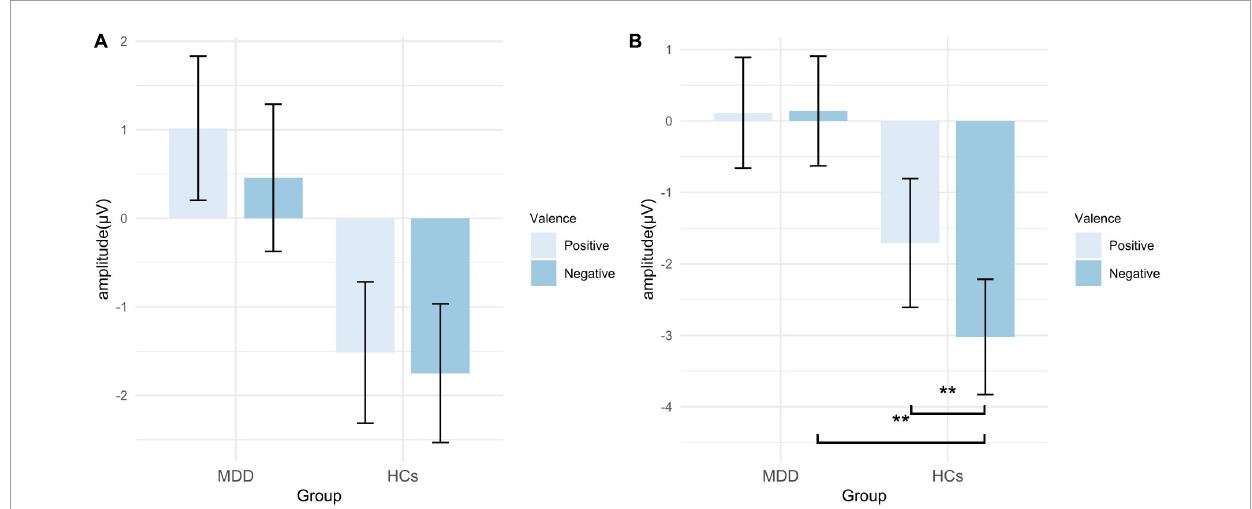
FIGURE4 Peak amplitude of N200 in EAST. (A) Amplitudes of self-words; (B) amplitudes of other-words. MDD, major depressive disorder; HCs, healthy controls; EAST, External Affect Simon Task; error bars represent the standard error. ** p < 0.01.